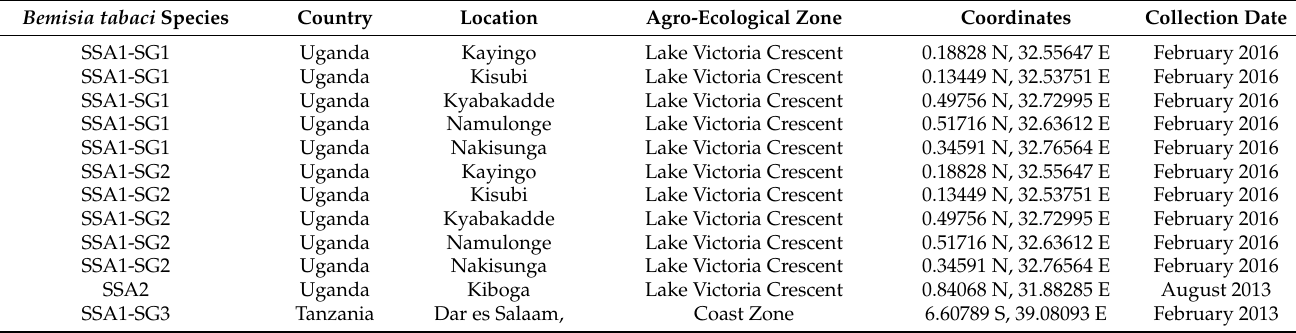
Table 1. Bemisia tabaci colonies collected from cassava in Uganda and Tanzania and maintained on eggplant at the Natural Resources Institute,